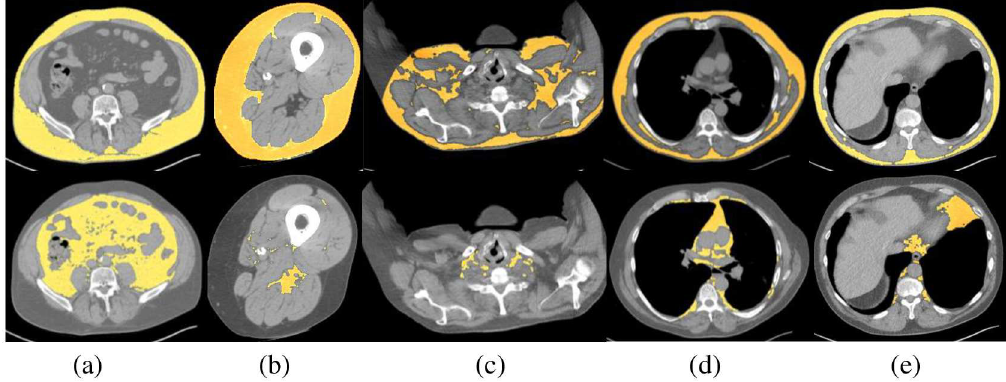
Fig 3. SAT (top row) and VAT (bottom row) segmentation from images of one subject overlaid on slice display for: (a) abdomen, (b) thigh, (c) slice in upper thorax, (d) slice in mid thorax, and (e) slice in lower thorax at level of diaphragm.